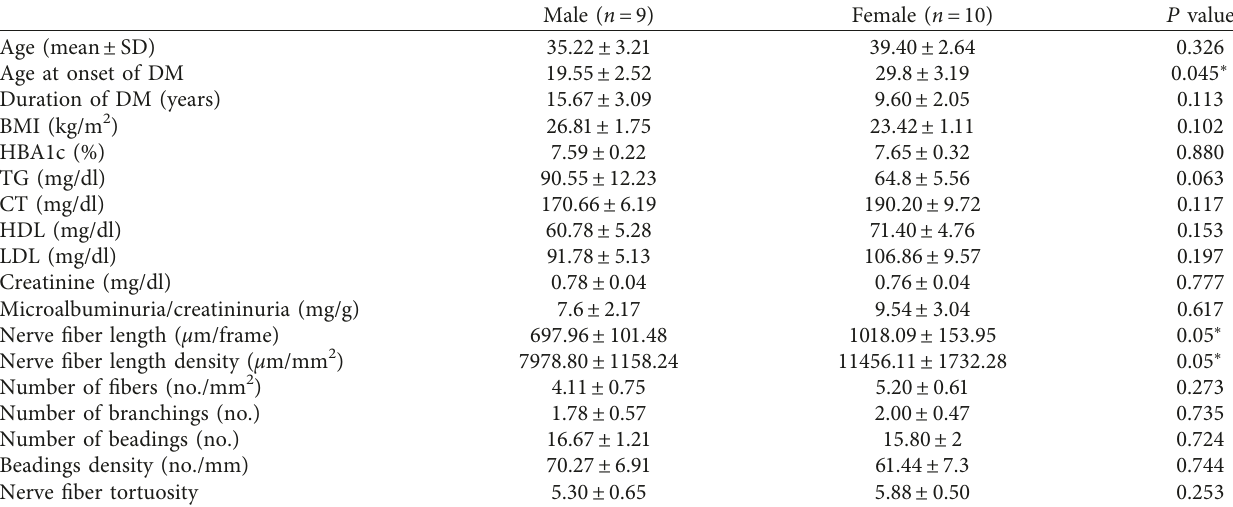
Table 5: Comparison between male and female in the T1DM population.